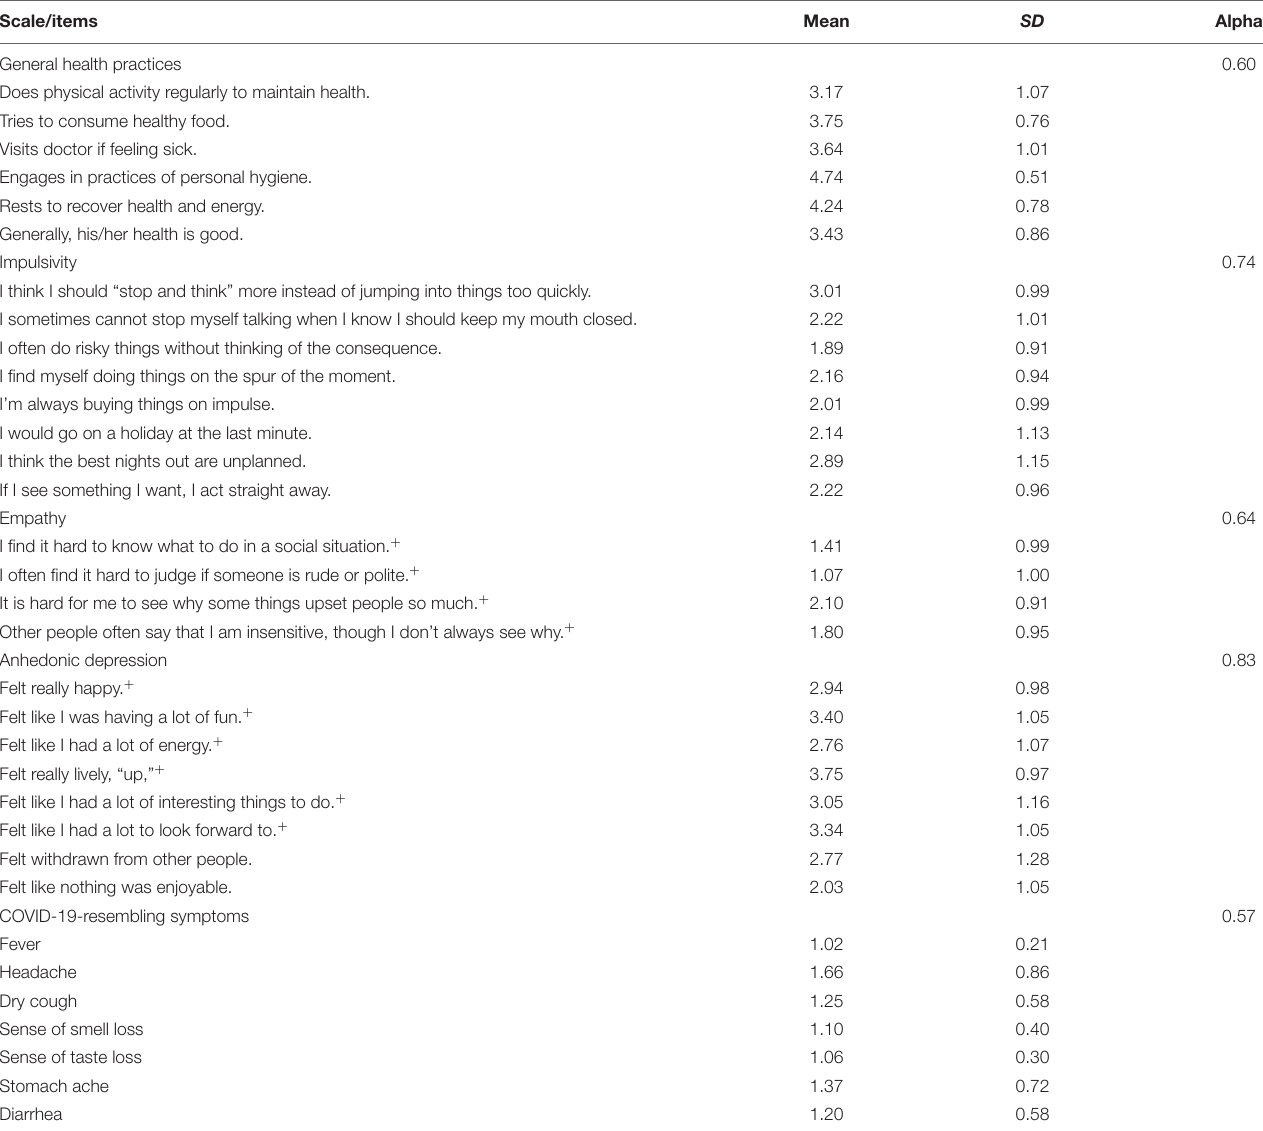
TABLE 1 | Reliability and univariate statistics of scales (scale range of responses: 1–5).